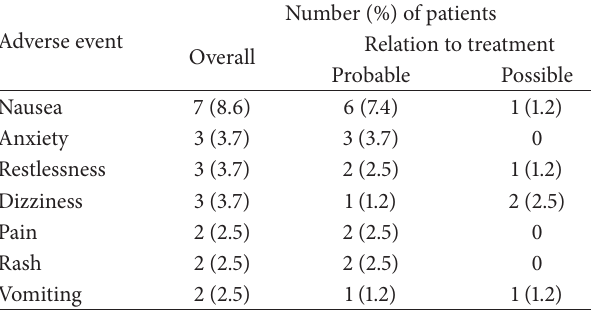
Table 3: Most frequently reported a AEs during 3 months of nightly treatment with transdermal rotigotine in the safety population ( 𝑛 = 81